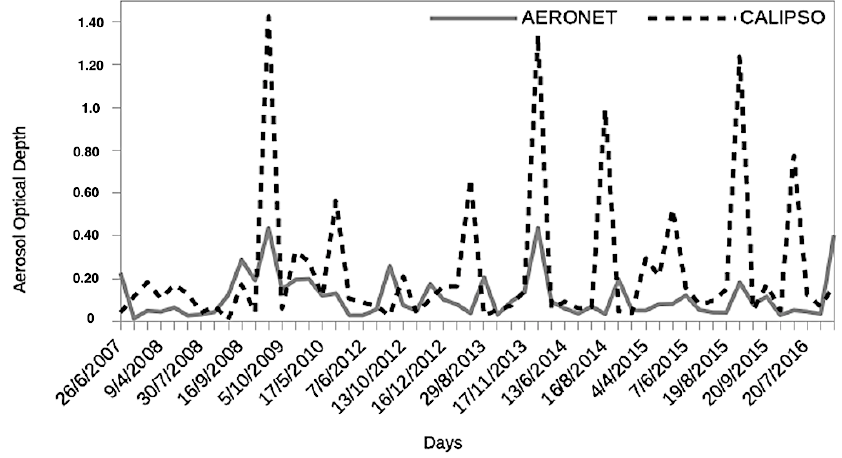
Figure 6. AOD time series from the AERONET sun photometer (solid line) and CALIPSO (dotted line) for the city of Petrolina, from 2007 to 2016.